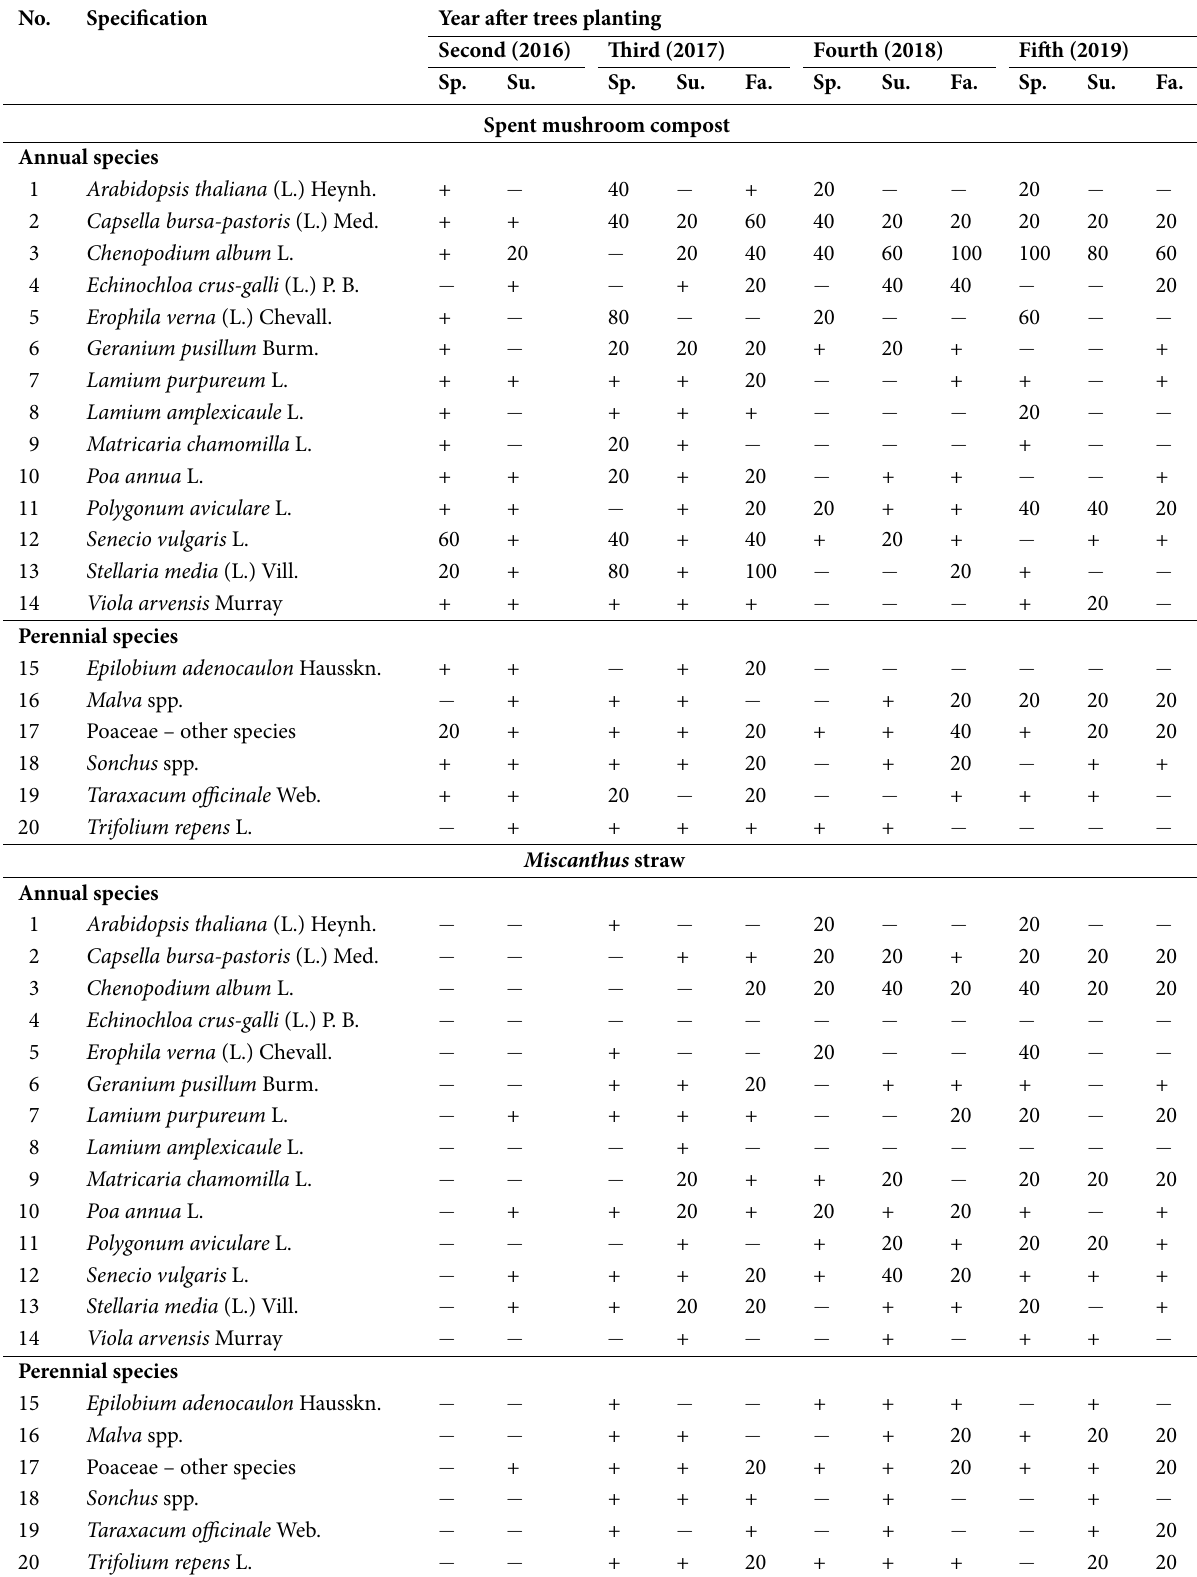
Table 3 Changes in the mean percentage soil surface under coverage of different weed species in tree rows receiving application of organic mulches in the years 2016 to 2019. No.